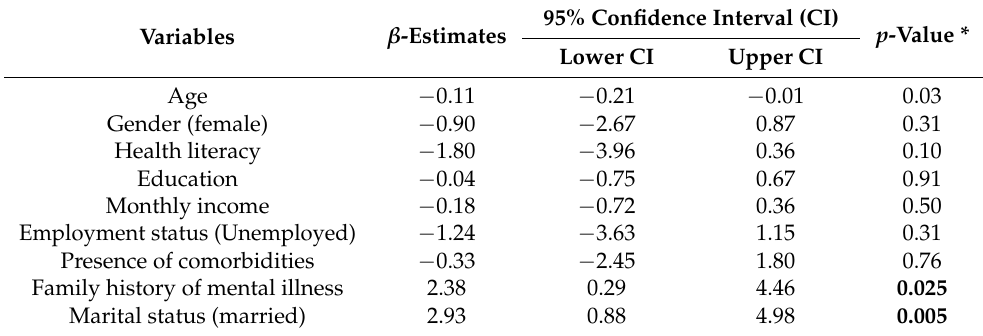
Table 4. Multiple linear regression for the association of EMIC stigma score and different factors. Variables β -Estimates * Values in bold represent significant p -values at